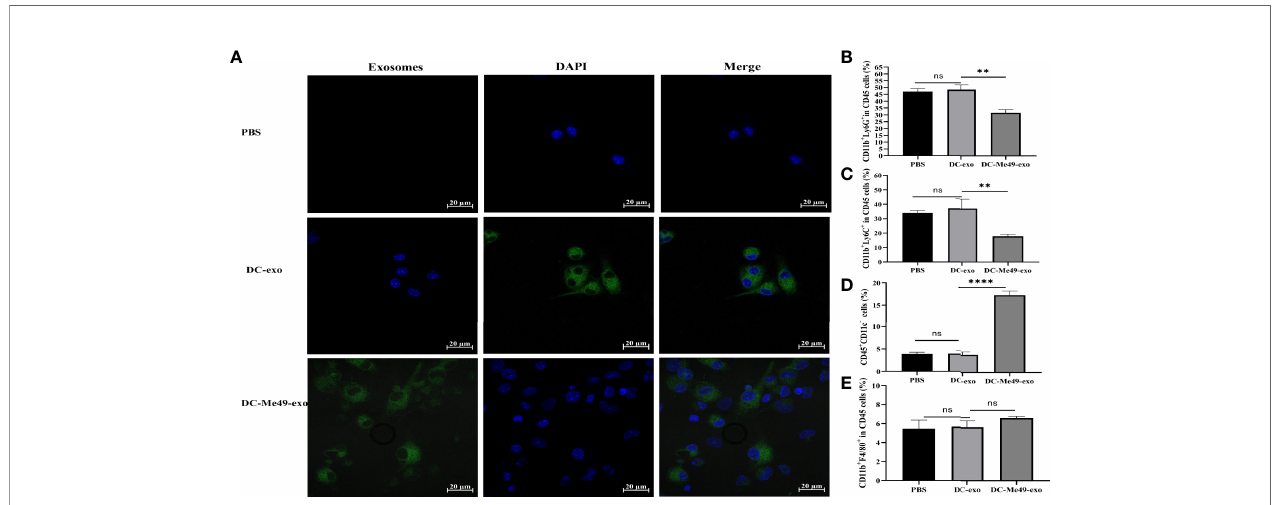
FIGURE 5 | DC-Me49-exo inhibited the proportion of MDSCs in vitro . (A) Uptake of exosomes by MDSCs. Exosomes were stained green with ExoSparker Exosome Membrane Labeling Kit-Green dye and nuclei were stained blue with DAPI after 24 h co-culture with MDSCs. Scale bar: 20 µm. FCM analysis of G-MDSC